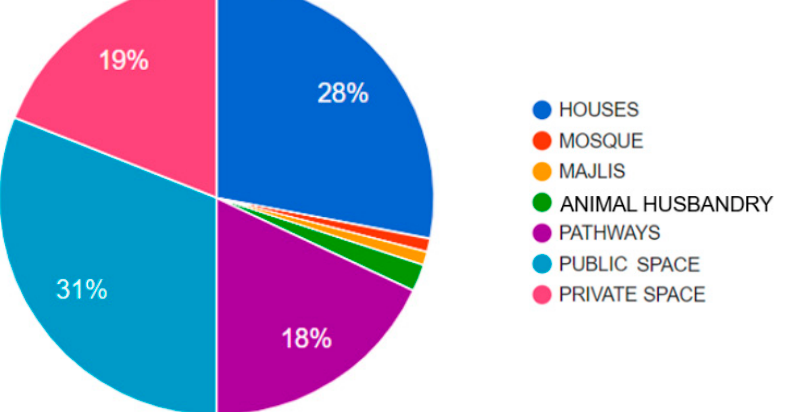
Figure 6. The pie chart indicates the percentage of different land use areas. The summation of both the public spaces and the pathways occupy 48% of the village area that is almost equal to 47%, the sum areas of the houses and their private spaces (courtyards). The remaining land uses only 5%.